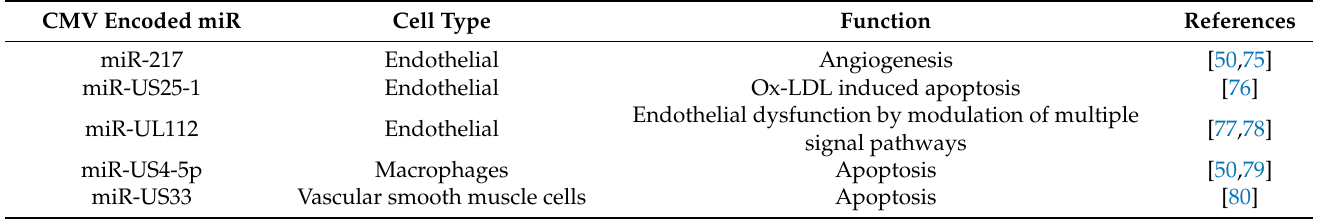
Table 3. CMV encoded miR according to cell type function in